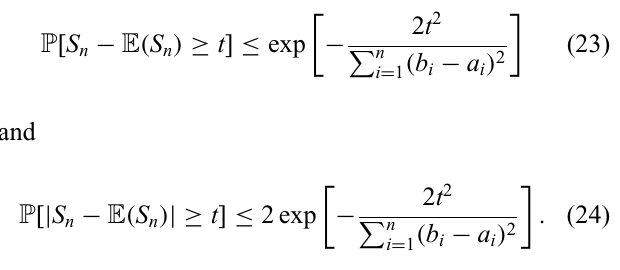
FIG. 3. The (upper) tail of a random variable X is the proba- bility of X being greater than some threshold t . This probability is given by the corresponding area under the graph of the probability density function (PDF) of X